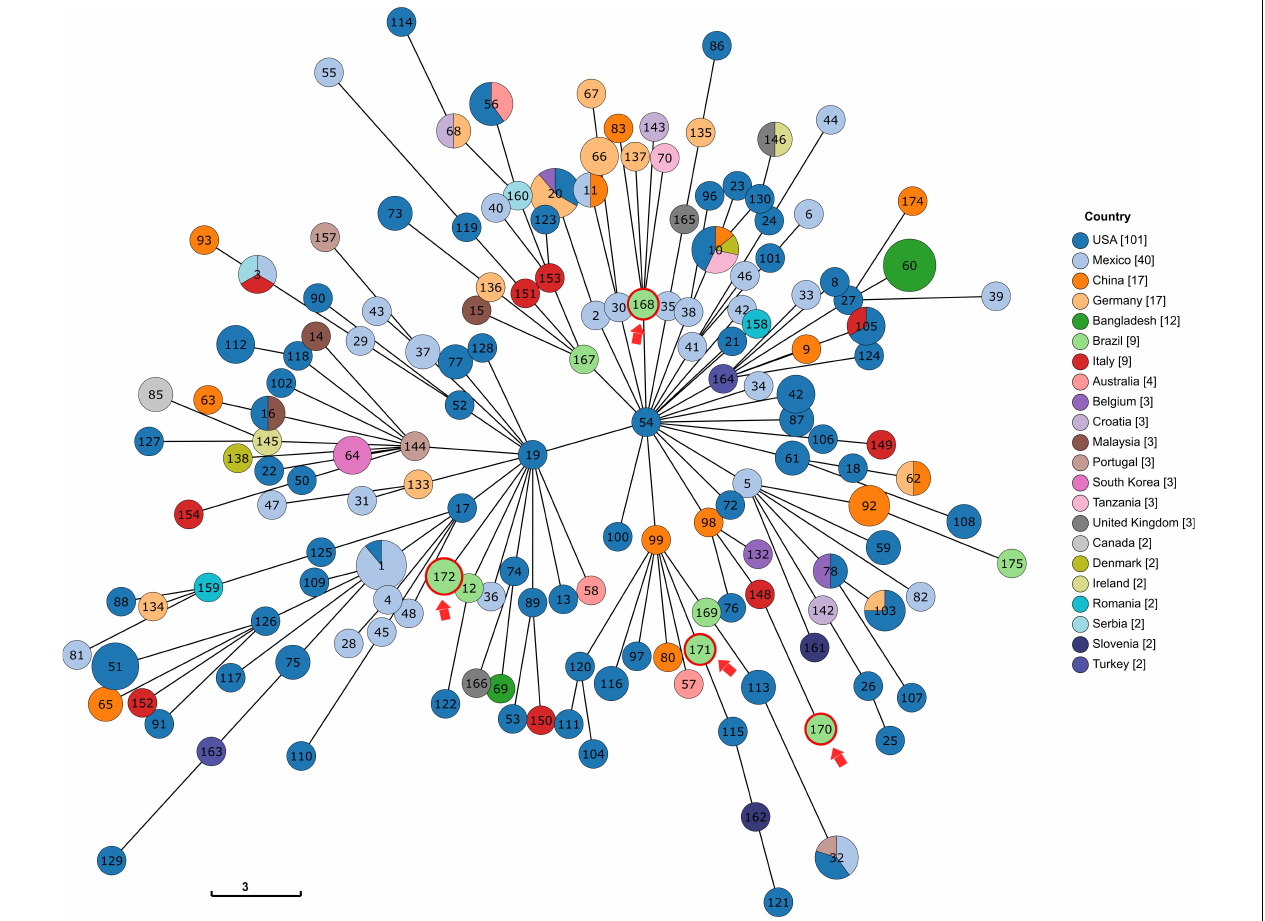
FIGURE 2 | Tree representation of the genetic relationships among the different profiles of the K. variicola MLST scheme, produced via GrapeTree with the minimum spanning tree algorithm (MSTree V2). The STs identified in this study are shown with a red arrow. For readability purposes, all the genomes that were the only representant of a country were